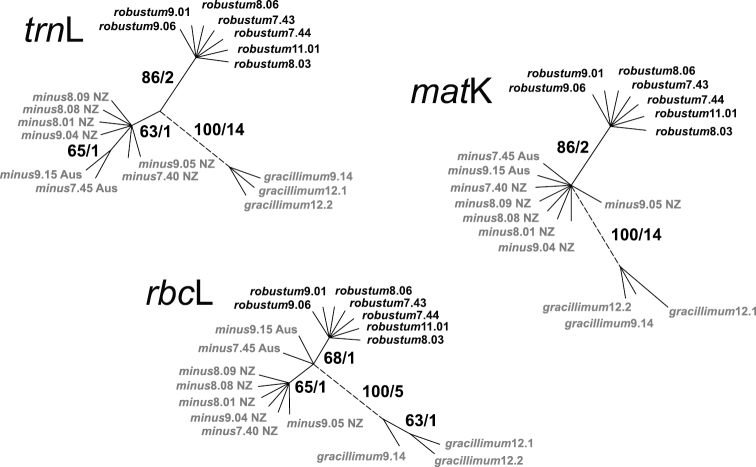
Comparison of median networks from independent analyses of trnL, rbcL and matK sequences. Bootstrap values / the number of mutations distinguishing each haplotype. are shown beside the branches. The accessions of Empodisma minus from New Zealand are indicated NZ and Australia Aus.